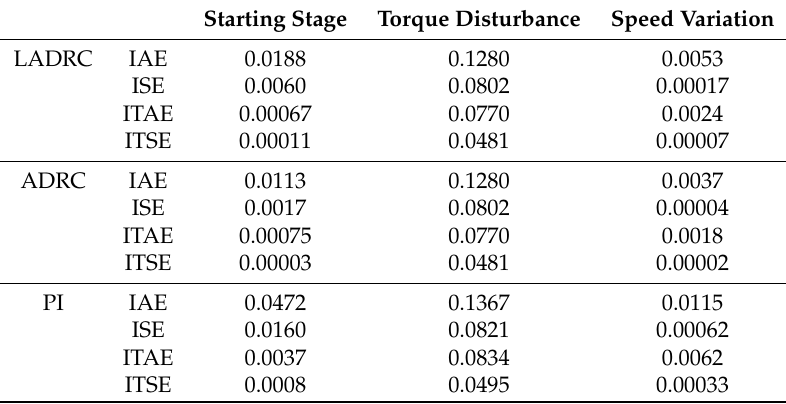
Table 4. Performance indices of the current control loop.